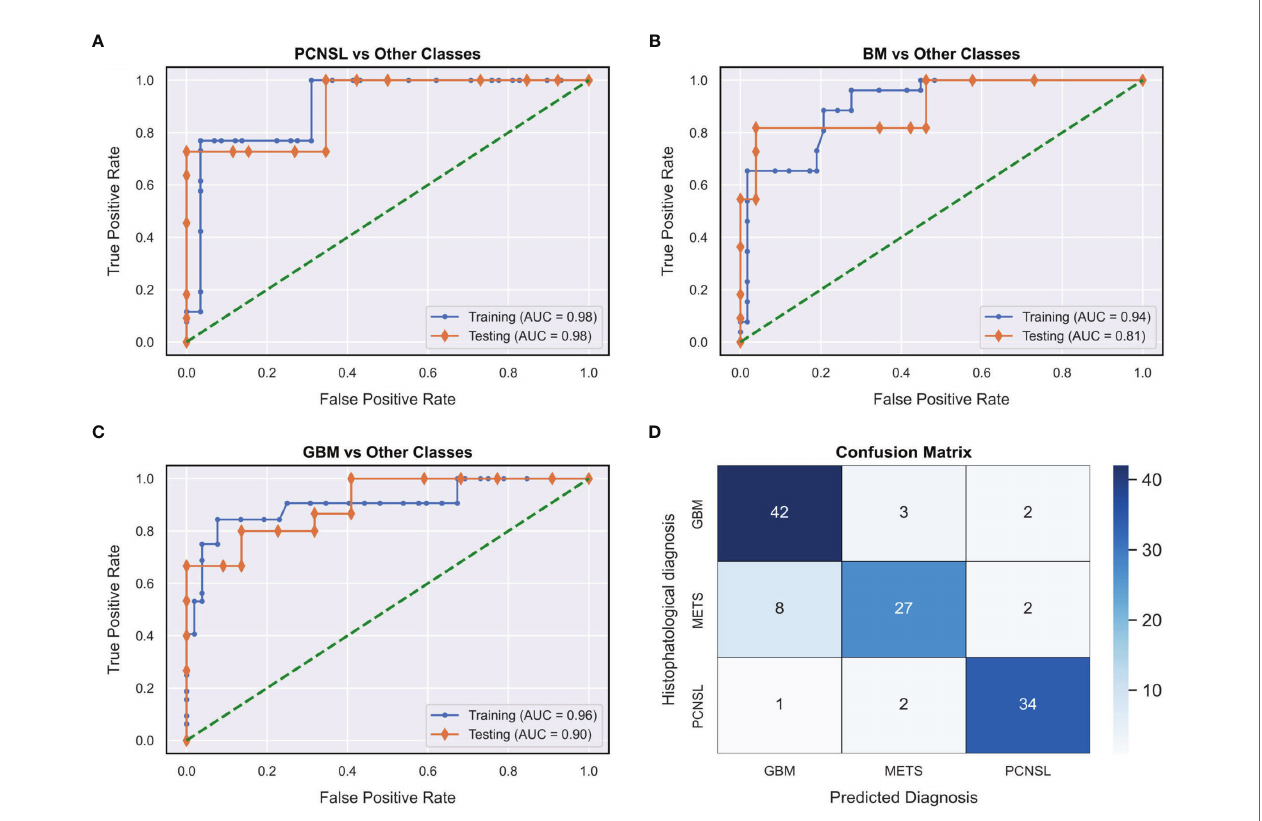
FIGURE 3 | AUC-ROC curves (on both training and hold-out test sets) for each diagnostic outcome class [One-vs-Rest: (A – C) ] and global confusion matrix (D) . GBM, glioblastoma; PCNSL, primary central nervous system lymphoma; METS, brain